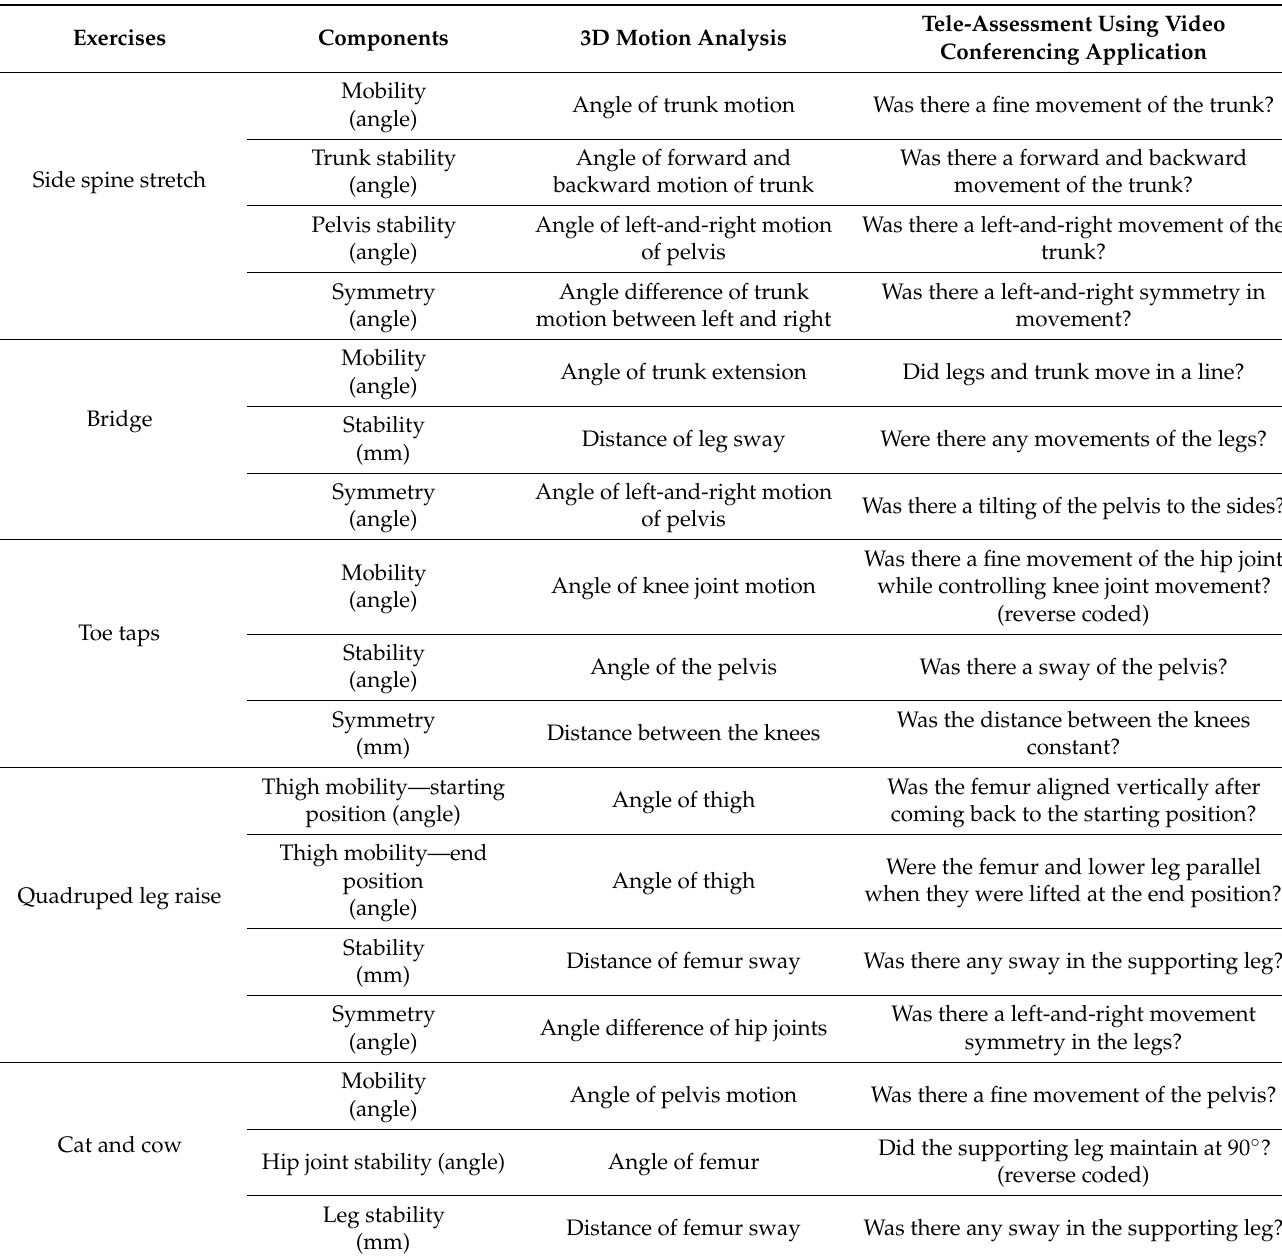
Table 1. List of exercise components analyzed with 3D motion analysis and tele-assessment using a video conferenc- ing